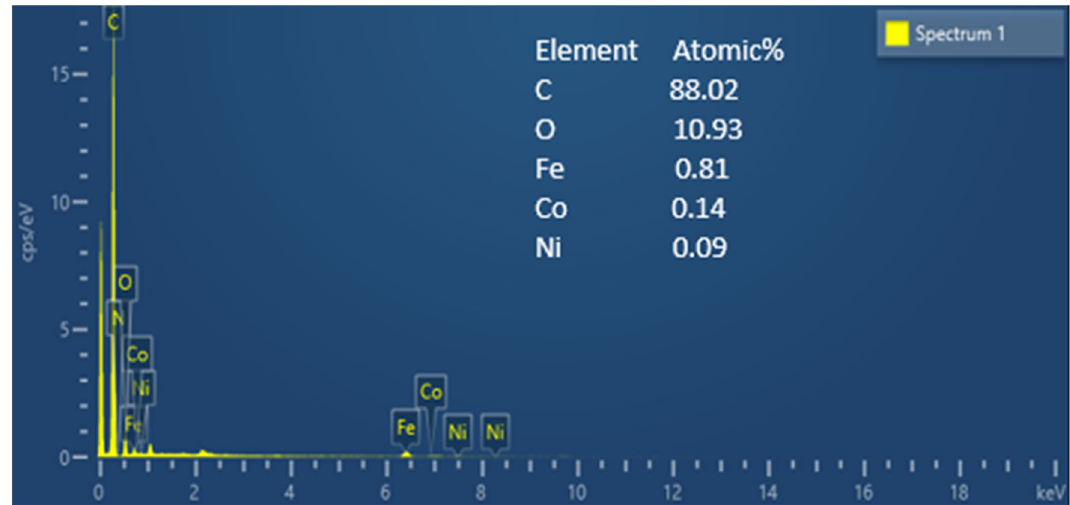
Figure 3. Elemental EDAX analysis of the Ni 0.5 Co 0.5 Fe 2 O 4 @AC/Ch magnetic